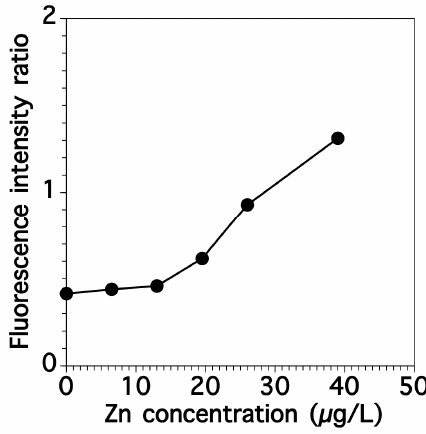
Figure 7. Effect of Zn concentrations on fluorescence intensity ratio (F539/F562) in the sample containing Cd (0.3 μ M).